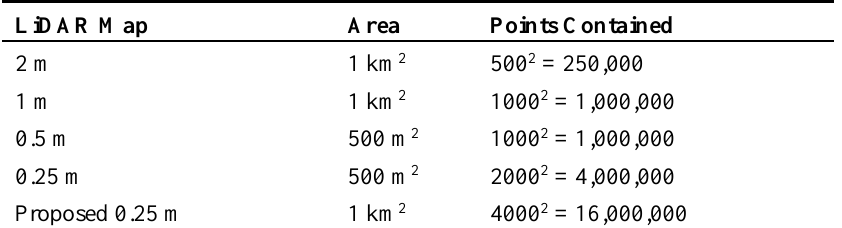
Figure 4. LiDAR coverage of the UK. ( A ) 2 m resolution, ( B ) 1 m resolution, ( C ) 0.5 m resolution, and ( D ) 0.25 m resolution. Table 1. LiDAR data